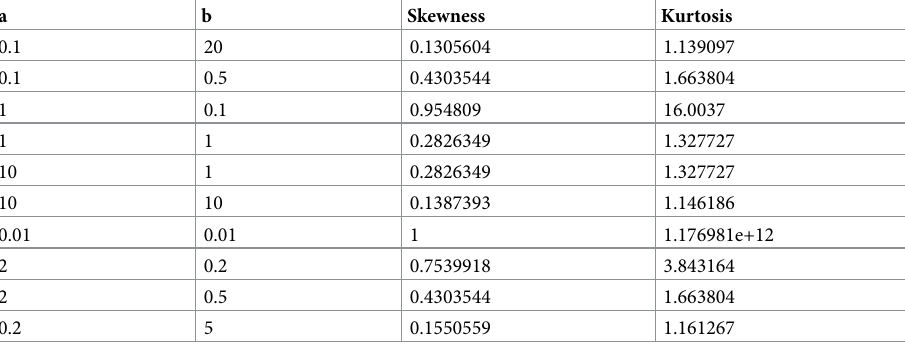
Table 2. Skewness and kurtosis for different values of